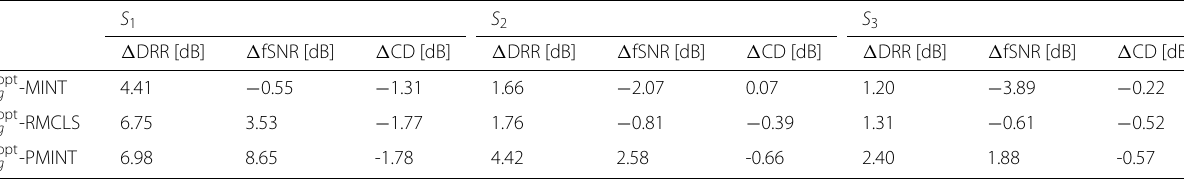
Table 6 Average performance of MINT, RMCLS, and PMINT using the optimal intrusively determined reshaping filter length L opt g S 1 S 2 S